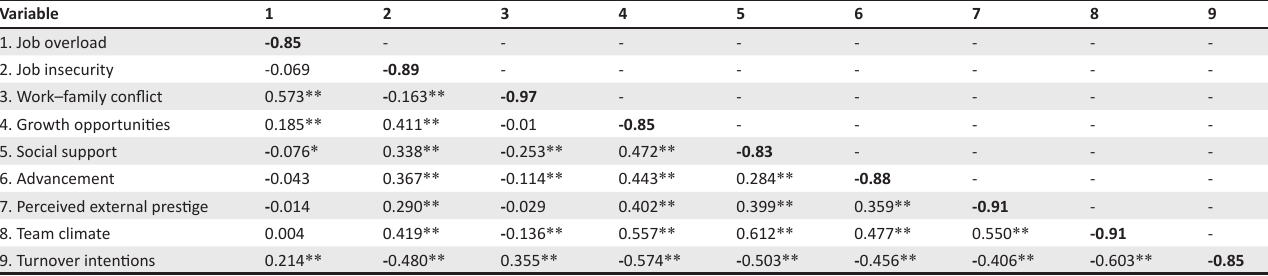
TABLE 1: Correlations between the study variables and internal consistencies (Cronbach’s coefficient alphas on the diagonal). Variable